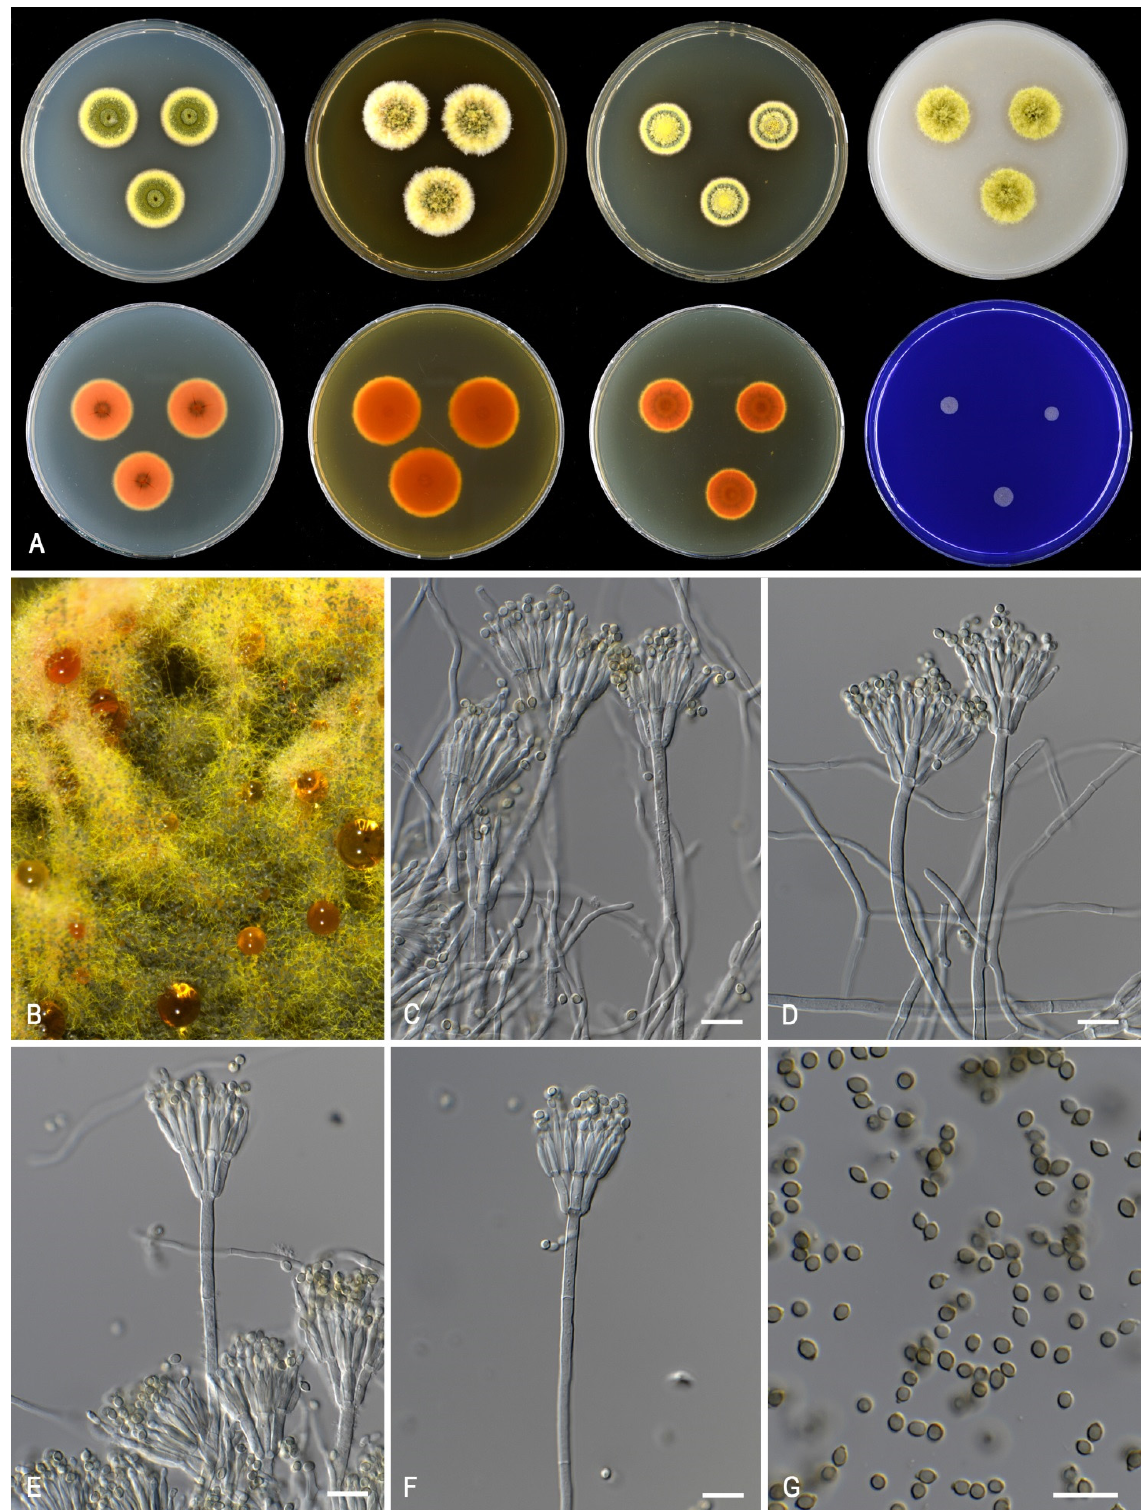
Figure 8. Morphological characters of Talaromyces gaditanus (CBS 169.81). ( A ). Colonies, from left to right, after 7 d at 25 °C (top row) CYA, MEA, YES, OA; (bottom row) CYA reverse, MEA reverse, YES reverse, CREA. ( B ). Detail of colony on MEA. ( C – F ). Conidiophores and conidia. ( G ). Conidia. Scale bars = 10 μ m.